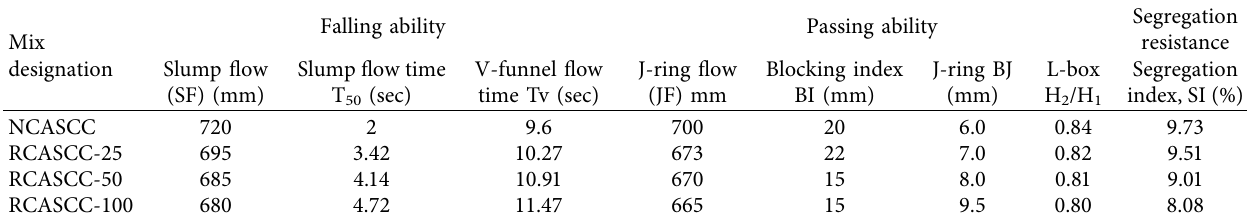
Table 5: Fresh properties of SCC.